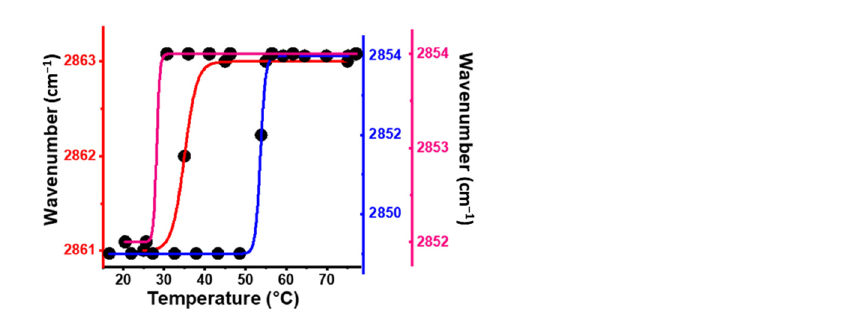
Figure 6. Schematic representation of the gold nanoantennas showing the geometric parameters used in the FDTD simulation.